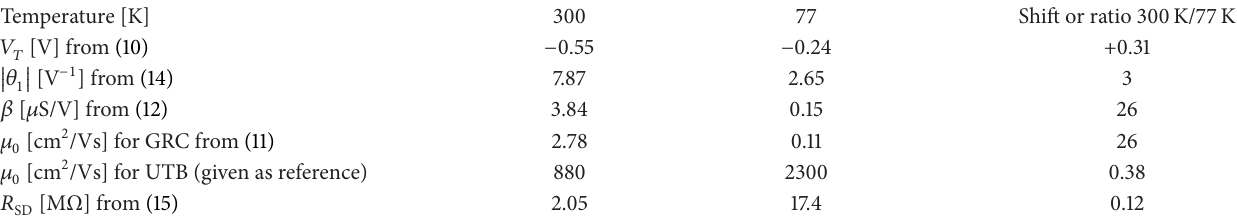
Table 2: Summarizing table of the extracted parameters for GRC’s having 𝑊/𝐿 ratio of 80 𝜇 m/8 𝜇 m at 𝑉 and 77 K. Threshold voltage 𝑉 𝑇 is extracted from the 𝑌 function while the 𝜃 1 factor is extracted from the 𝑍 function. The 𝛽 parameter and the subsequent saturation mobility 𝜇 0 are extracted from the 𝑌 function slope. Extracted series resistance 𝑅